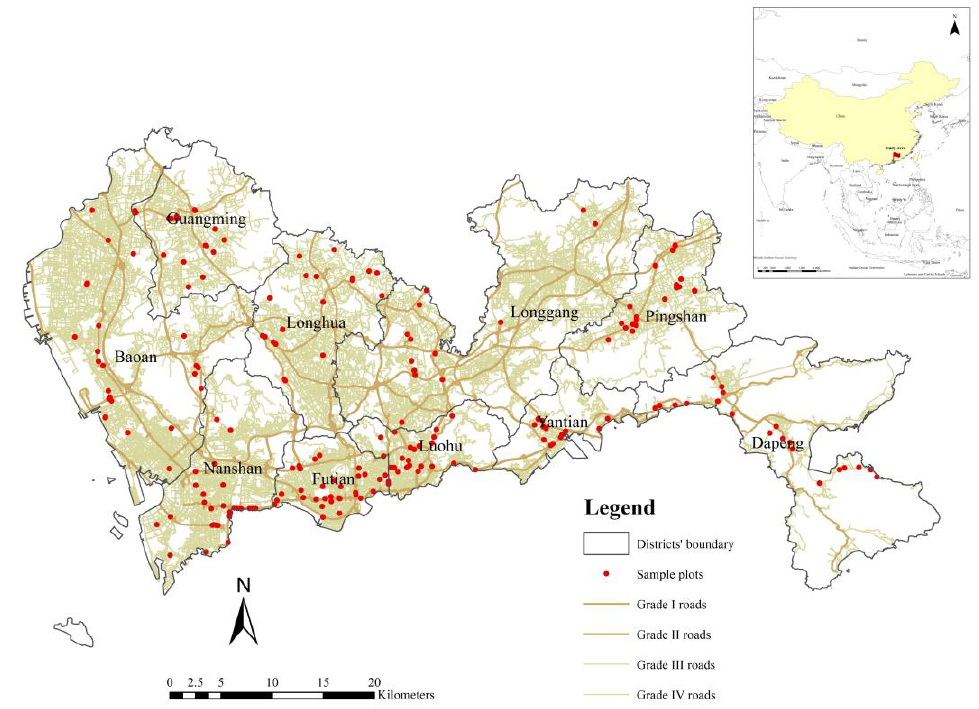
Figure 2. The location of Shenzhen City and the distribution of noise monitoring points in it.